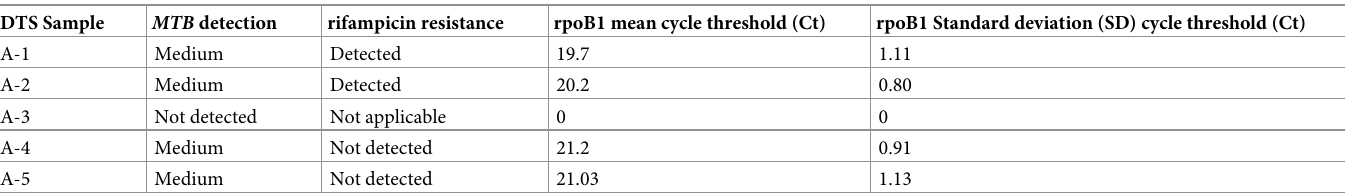
Table 2. Summary of the validation results (n = 20 per sample).